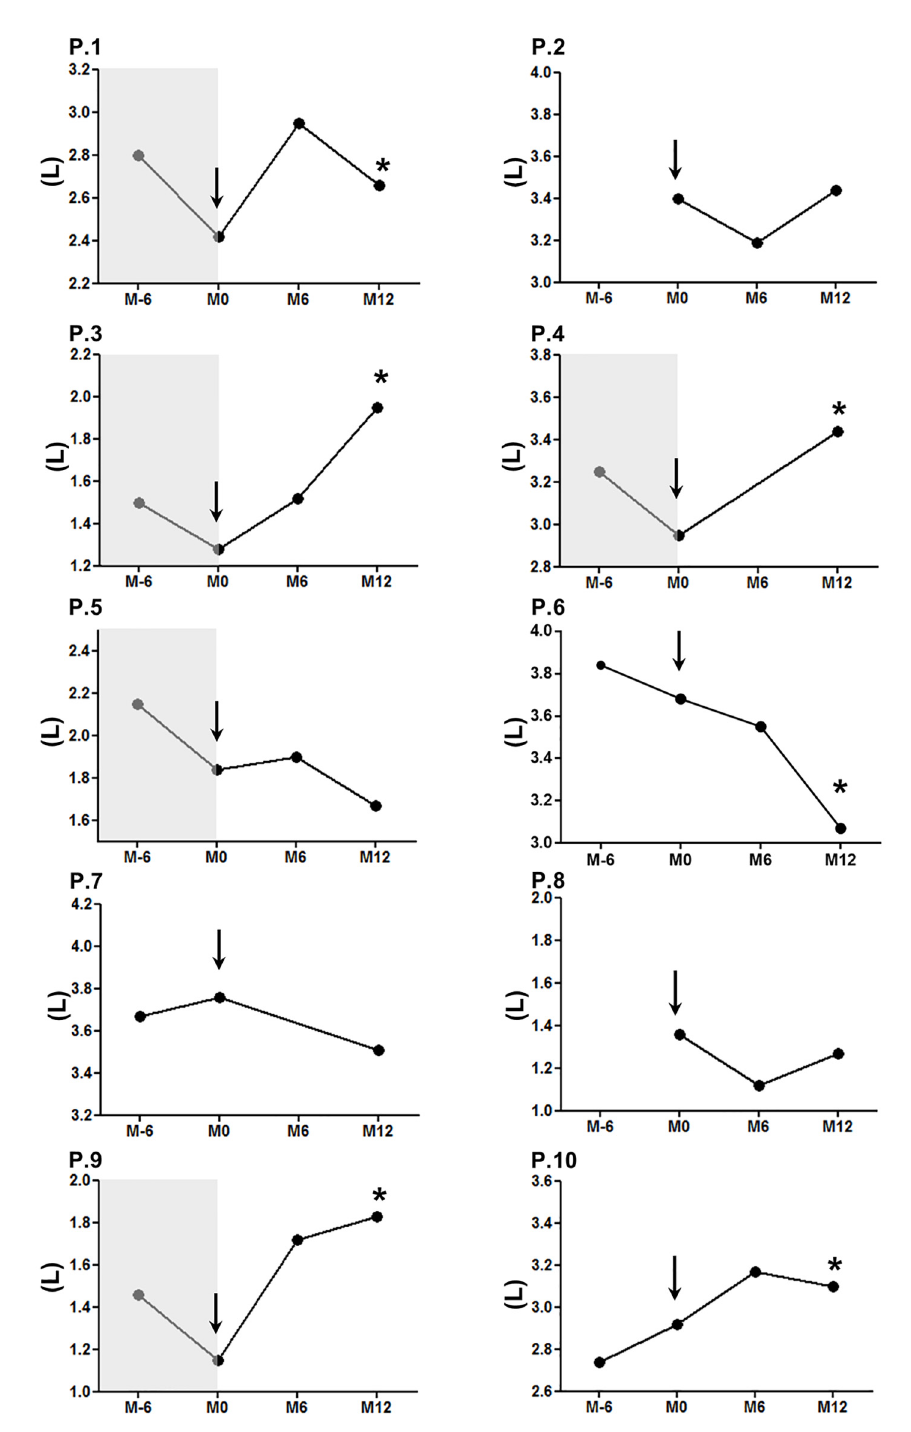
Fig 4. Forced vital capacity evolution. Forced vital capacity (FVC) is represented for each patient who terminated the study and had interstitial lung disease (ILD). FVC is represented 6 months before enrolment (M − 6), when available, and 6 and 12 months (M6 and M12) after the first rituximab infusion (arrow, M0). The grey area represents a decrease of (cid:3) 10% in absolute FVC at baseline compared with M − 6. ( * ) Represents an increase or a decrease of (cid:3) 10% of absolute FVC or (cid:3) 15% of DLCOcor at M12 compared with M0.